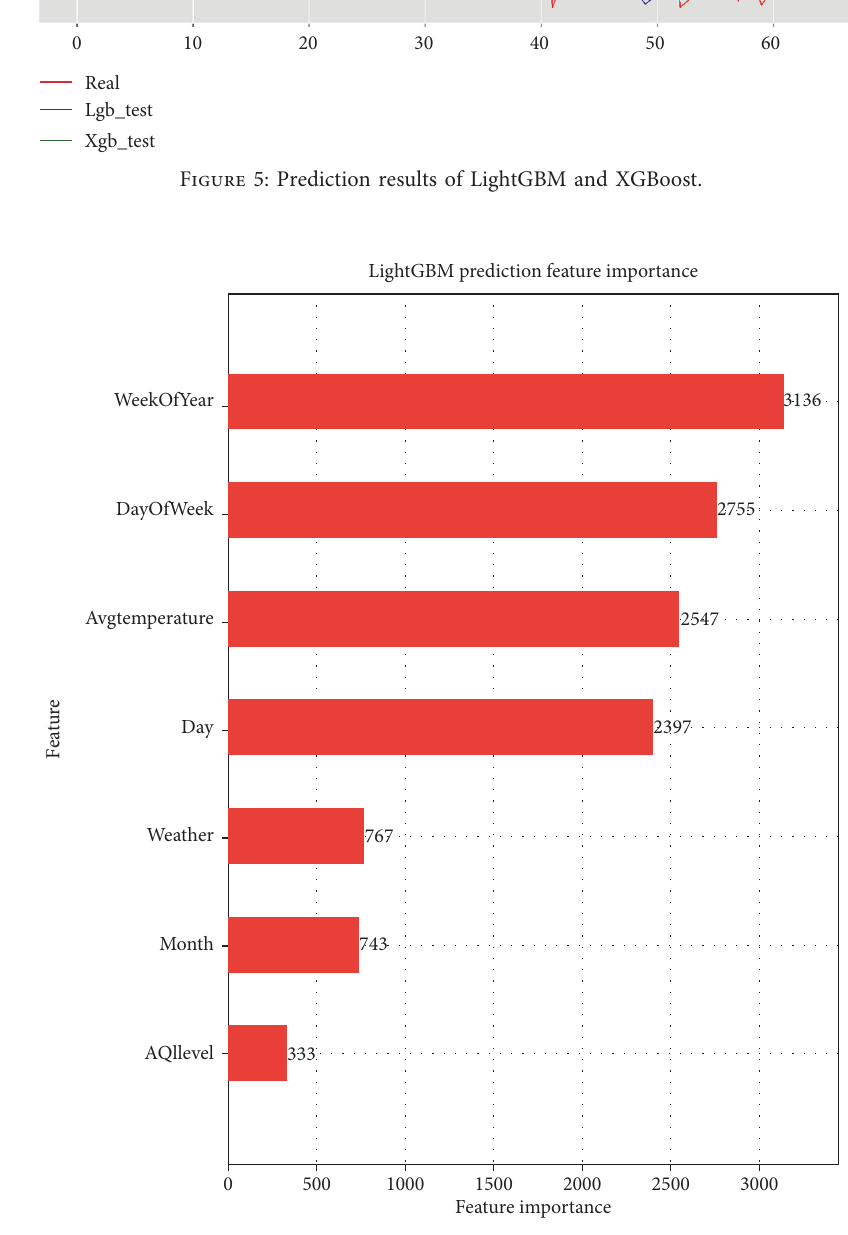
Figure 6: Importance of prediction model